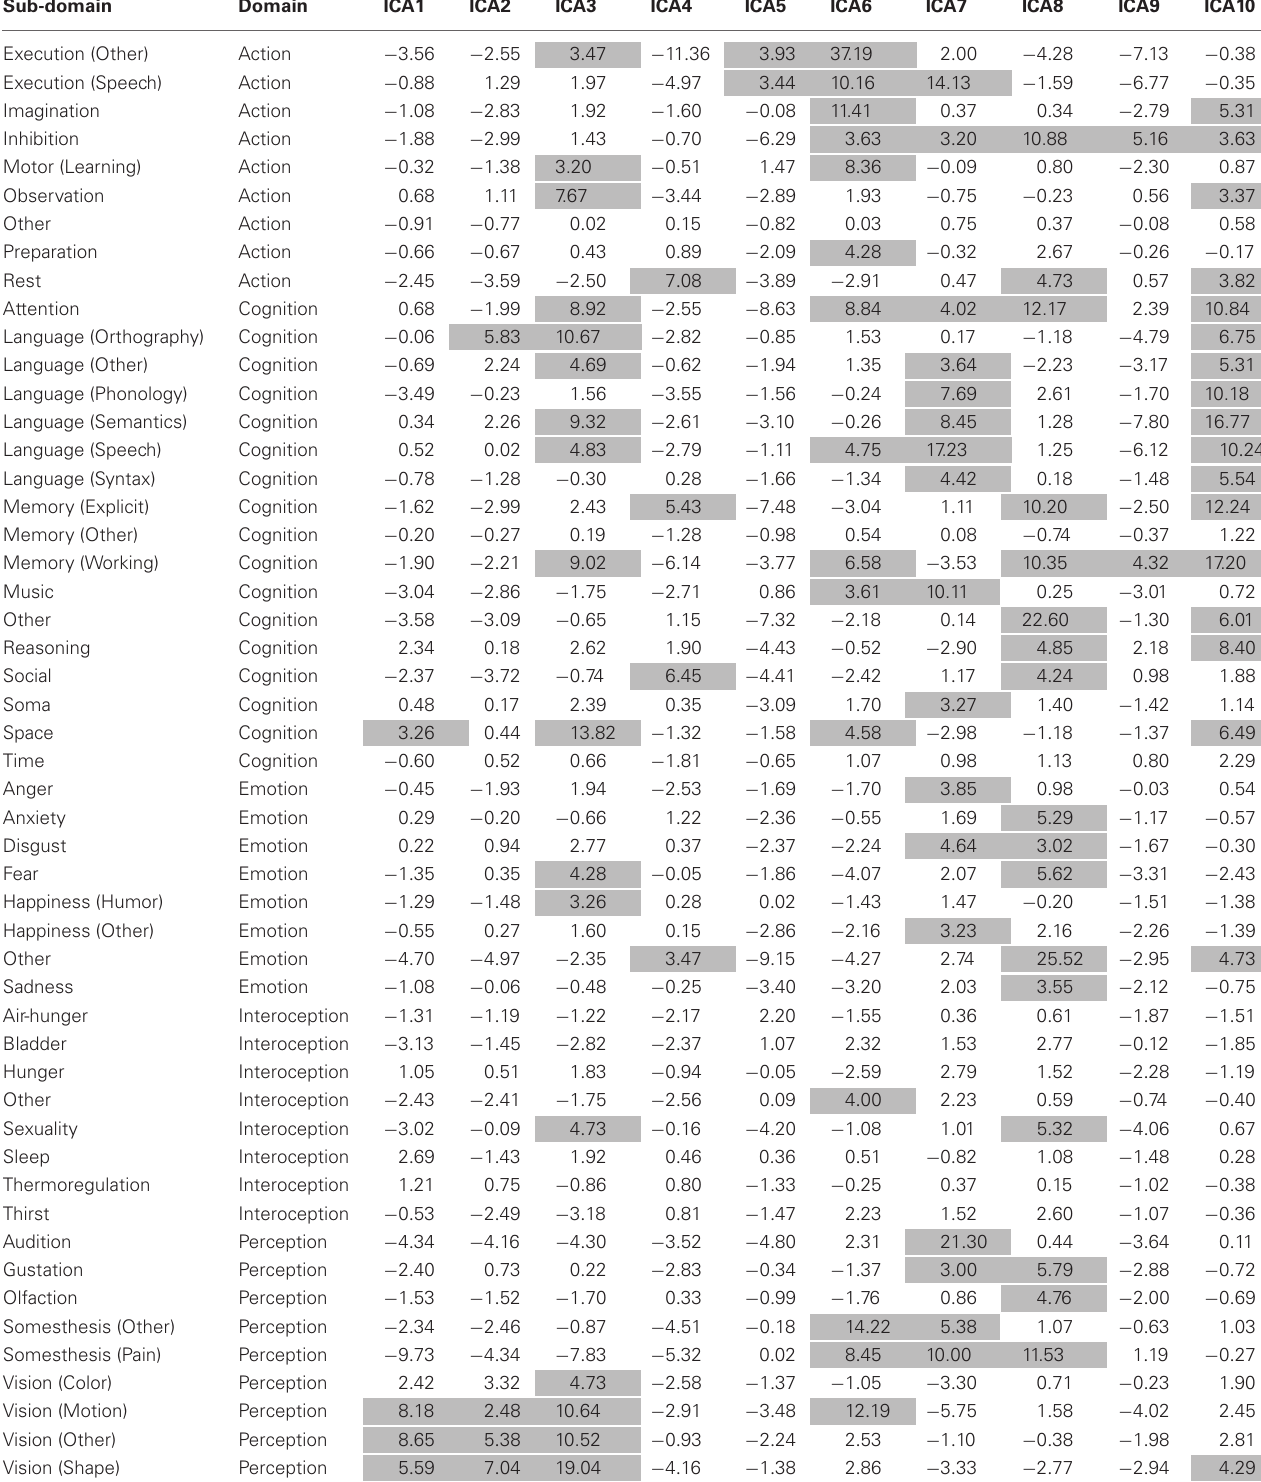
Table 5 | Behavioral analysis of ten major representative functional networks (Smith et al., 2009).